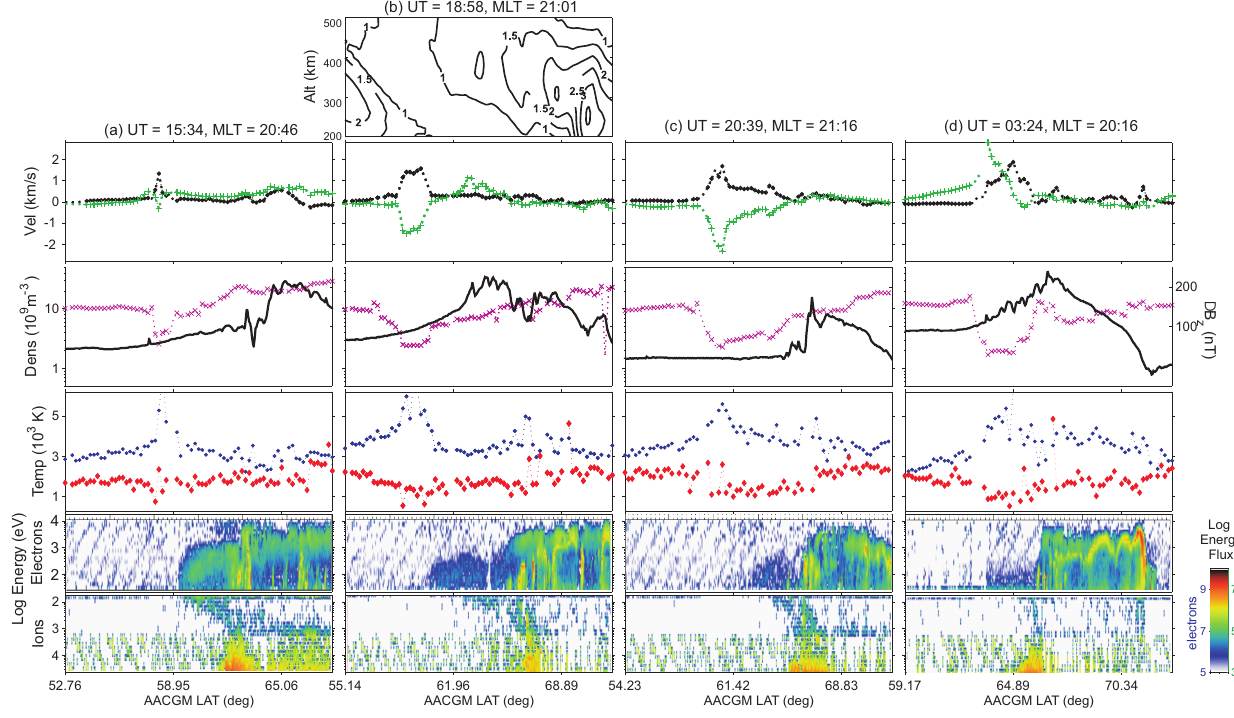
Fig. 1. The case of 21 September 2003. Each vertical set of panels (a–d) corresponds to a 5-min time interval from selected DMSP crossings when an ASAID (and, at the end, a SAID) was observed. A single plot has been added on top of panel (b) to show the results of a tomographic reconstruction of the electron density in the F-region, corresponding to the MLat where the ASAID was observed. UT and MLT of the beginning of each interval are placed on top of each vertical panel (for instance, in panel (a), the satellite is at 52.76 ◦ MLat at 15:34UT and 20:46MLT). For the DMSP data, the cells of the first row illustrate the profiles of the transversal and vertical ion drift velocity (green crosses: horizontal ion drift with positive values in the westward direction; black circles: vertical ion drift, positive values upward). The second row illustrates the profiles of the ion density (magenta “x” symbols) and of the magnetic deviation in the east-west direction (black curve). The third row illustrates the temperature profiles (blue asterisks: electron temperature; red diamonds: ion temperature). Markers show good data points. Finally, the last two rows display the electron (top) and ion (bottom) differential energy